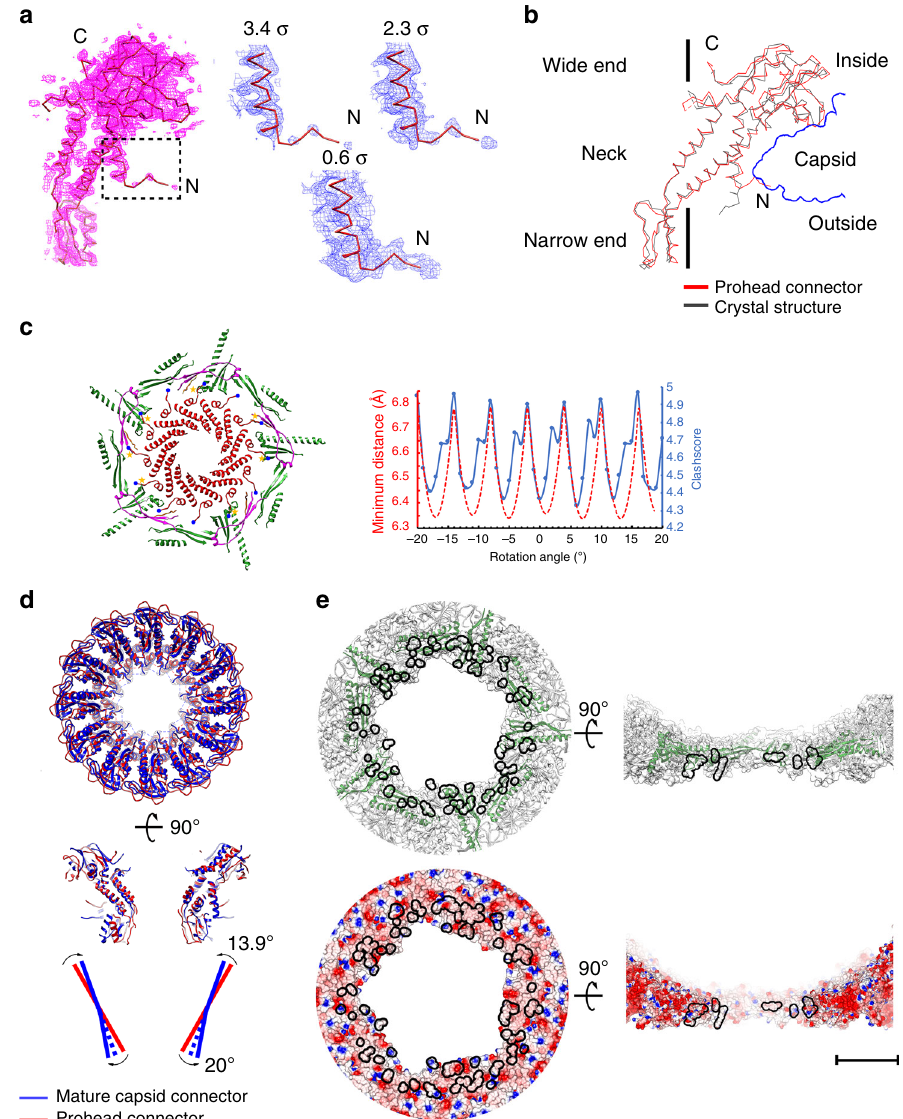
Fig. 5 Structure of the connector. a Left: a wire-frame structural model of a gp10 monomer shown in the prohead connector density. The density map of the prohead connector is drawn at a contouring level of 3.4 σ (magenta); right: zoom-ins showing the extended distal end of gp10 N-terminus at three different contouring levels. b Structure superposition of a prohead connector monomer (red) and a crystal structure connector monomer (black). The vertical black line indicates the position of the symmetry axis. c Left: ribbon diagrams showing the interactions between the prohead capsid and the gp10 N termini of a randomly placed prohead connector in a fi vefold reconstructed prohead connector envelope. The connector is colored red. The N termini of the gp10 monomers are marked with blue balls. Yellow stars indicate gp10 monomers that have steric clashes with the capsid. The HK97-P subdomains are colored green. The E loops are colored magenta; right: plots of the clashscores (blue solid line) and the minimum distances (red dash line) against the rotational positions of the connector. The connector positions were generated by rotating the connector around its 12-fold symmetry axis with a step size of 1 degree. The clashscore calculated using the program phenix.molprobity is de fi ned as 1000 × (number of bad overlaps)/(number of atoms). The minimum distance at each position was calculated using 12 Tyr122 C α atoms of the connector and 5 Trp156 C α atoms of the capsid. d Structure superposition of the prohead connector (red) and the mature head connector (blue) showing conformational changes of the connector upon head maturation. Top: top view; middle: side view; bottom: a schematic diagram showing possible level motion of the gp10 monomers. e Ribbon and shadowed-surface diagrams showing the contact sites of the connector to the mature capsid. The contacts are highlighted with black lines. Top: ribbon and shadowed-surface; bottom: electrostatic surface. Negative and positive electrostatic potentials are colored red and blue, respectively. The scale bar represents 5